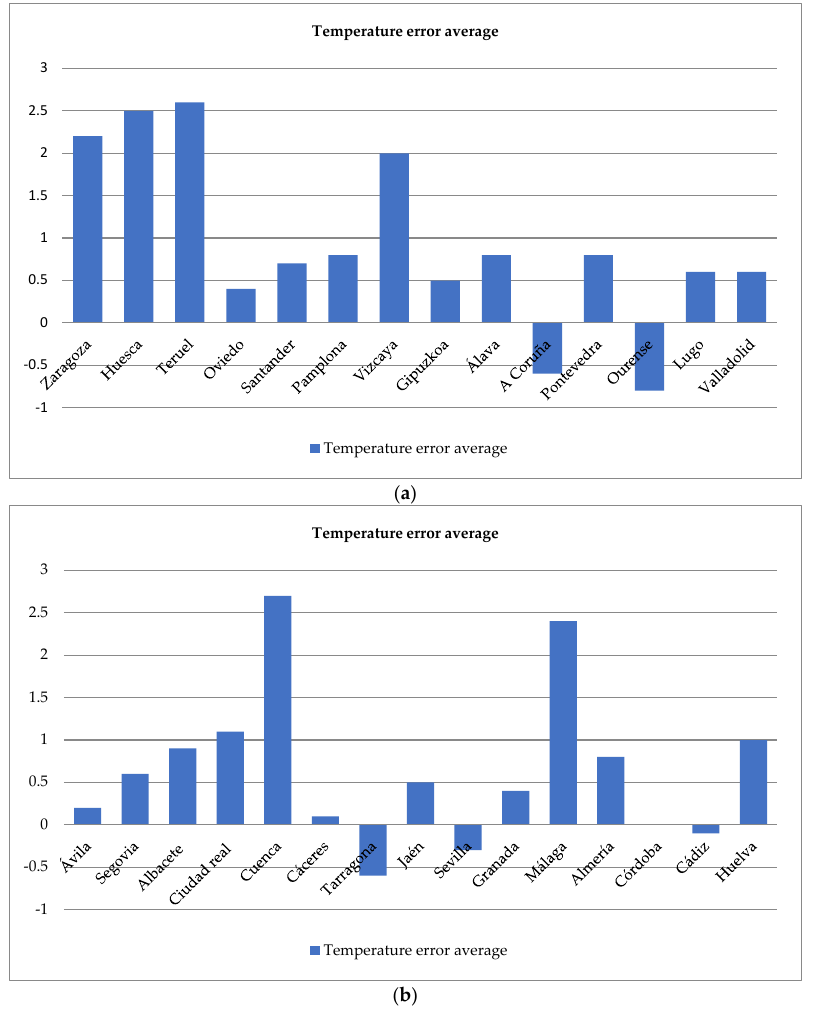
Figure 2. Temperature error average. The errors did not exceed 3 °C for the monthly average in temperatures in ( a ) either in ( b ).